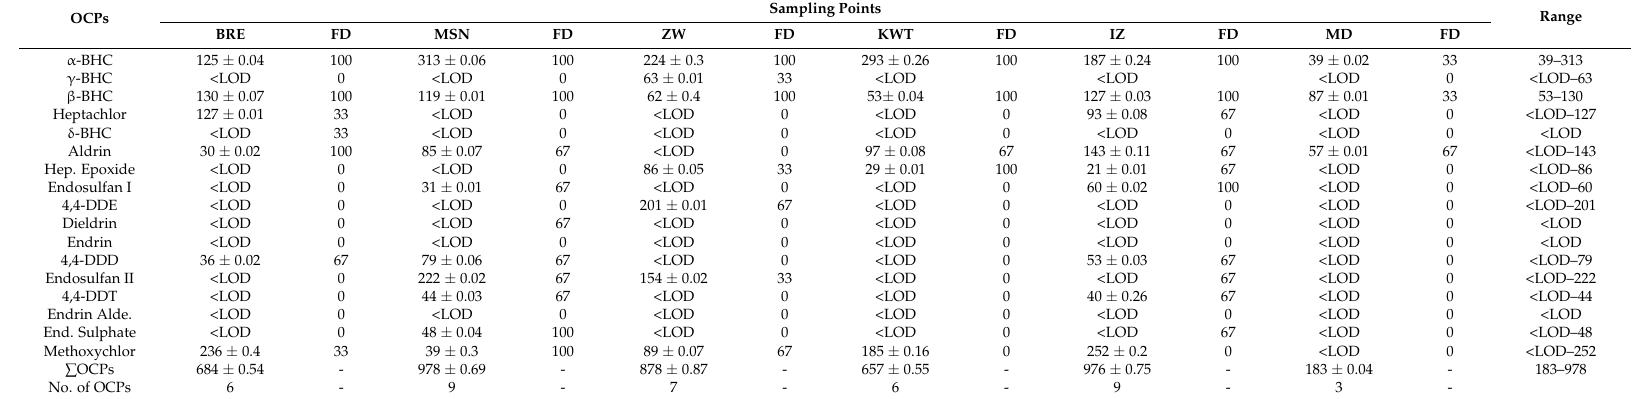
Table 4. Total concentration (ng/L) of OCPs in autumn in surface water along the course of Buffalo the River (Values are means ± SD; N = 3).